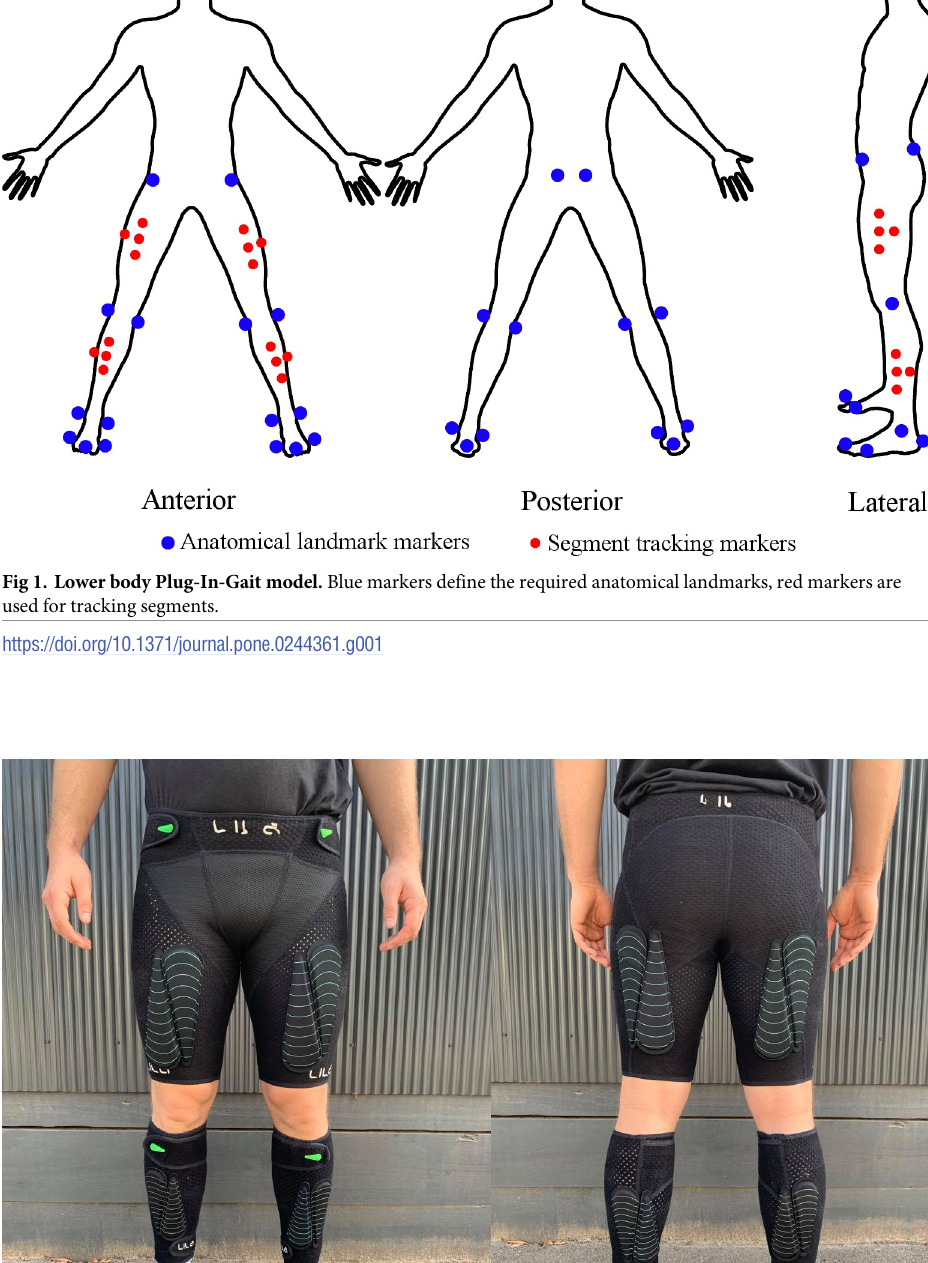
PLOS ONE | https://doi.org/10.1371/journal.pone.0244361 December28,